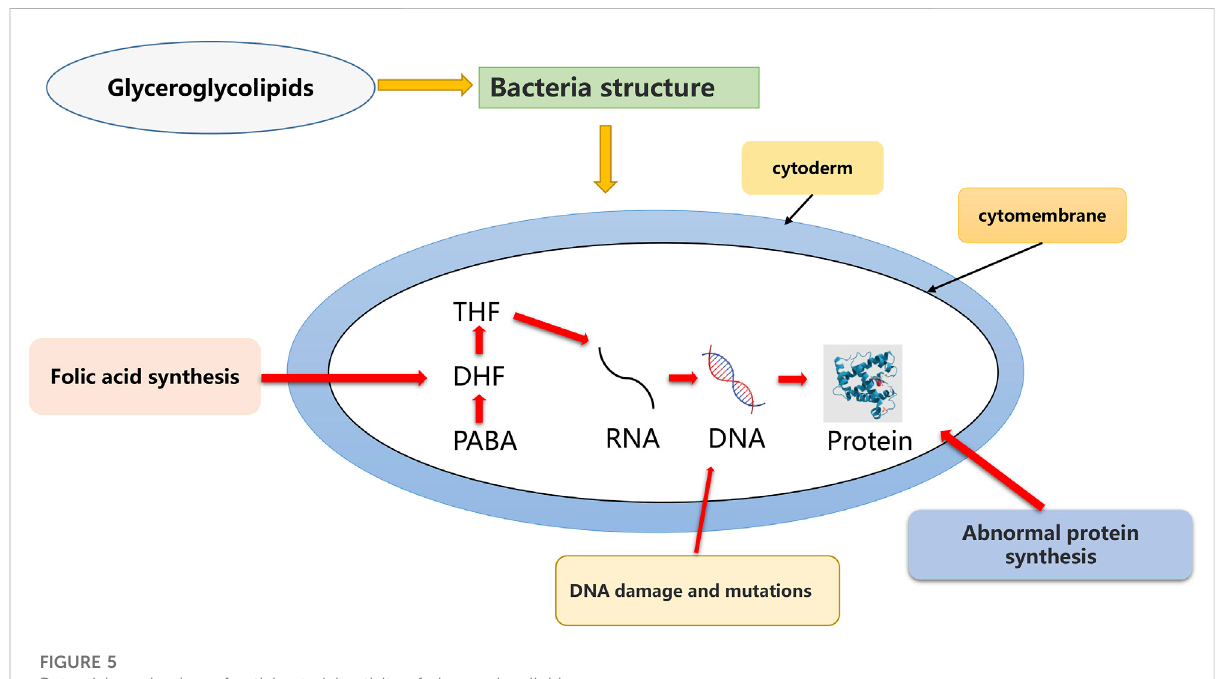
FIGURE 5 Potential mechanism of anti-bacterial activity of